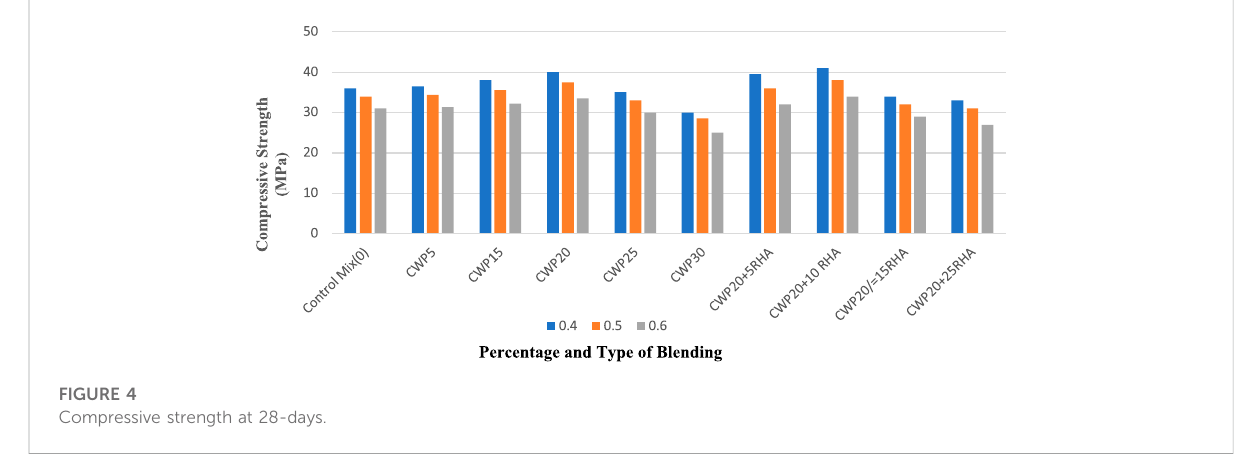
FIGURE 4 Compressive strength at 28-days.